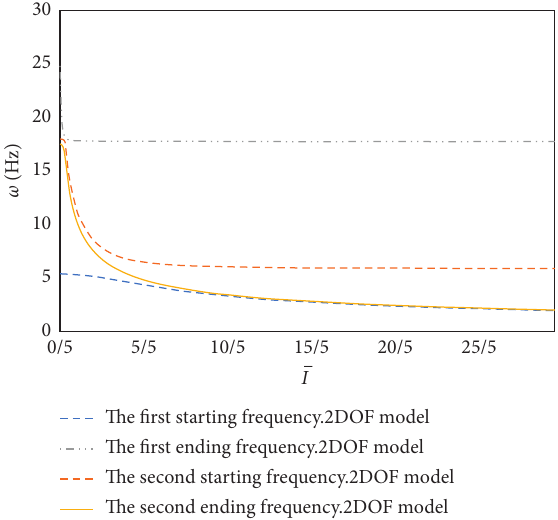
parameter on bandgap for the 2DOF 1